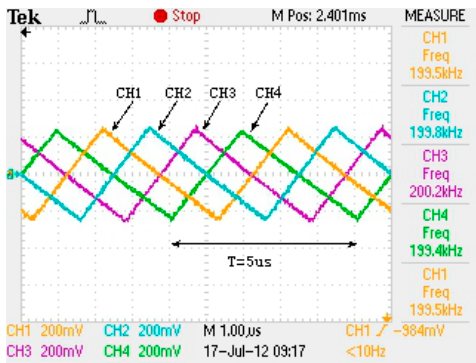
Figure 6. Four-phase signal (AC coupled).